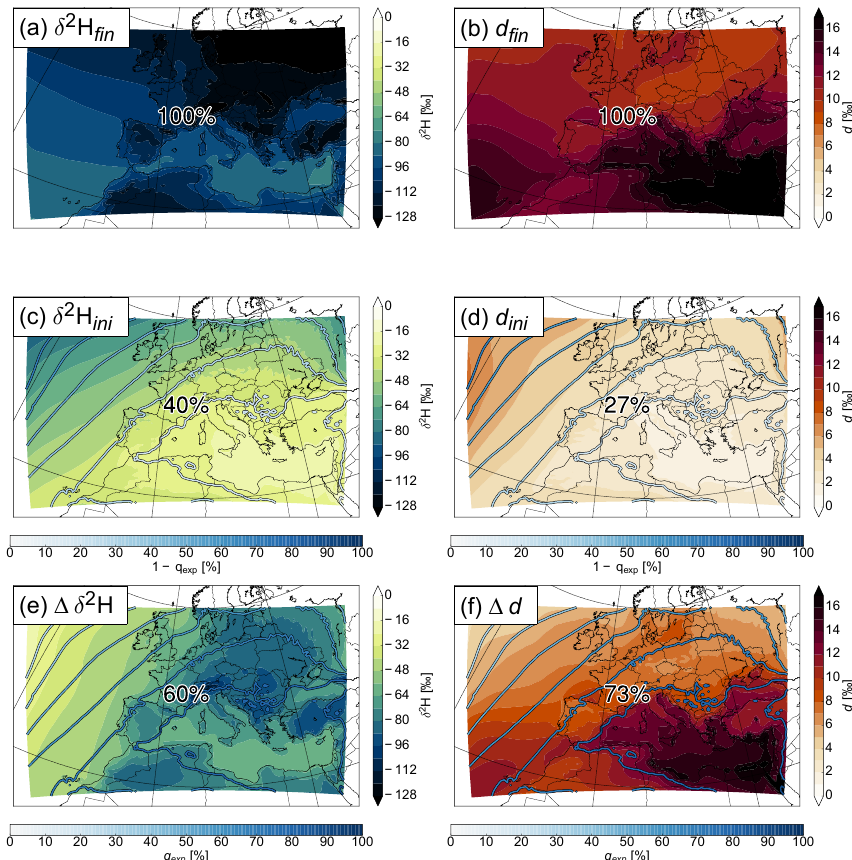
Figure 7. The 30-year mean of δ 2 H (a, c, e) and deuterium excess (b, d, f) in water vapour averaged over the first, third, and fifth lowest model level (a, b) , the weighted contributions of the initial values (c, d) , and changes along the trajectories (e, f) . The numbers show the mean contribution of each term to the final value ( δ 2 H fin and d fin ). The contours show 1 − q exp (c, d) and q exp (e, f) in